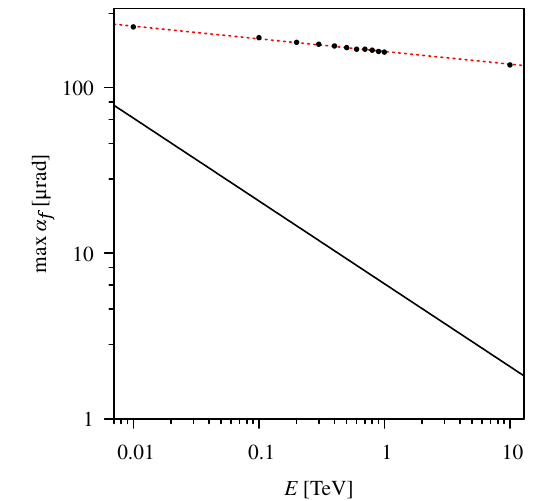
Fig. 6 The dependence of the maximum angle by which the fraction of particles f = 0 . 1 can be deflected on the particle energy on a double logarithmic scale. The black solid line shows the dependence of the critical angle of the planar channeling on the particle energy